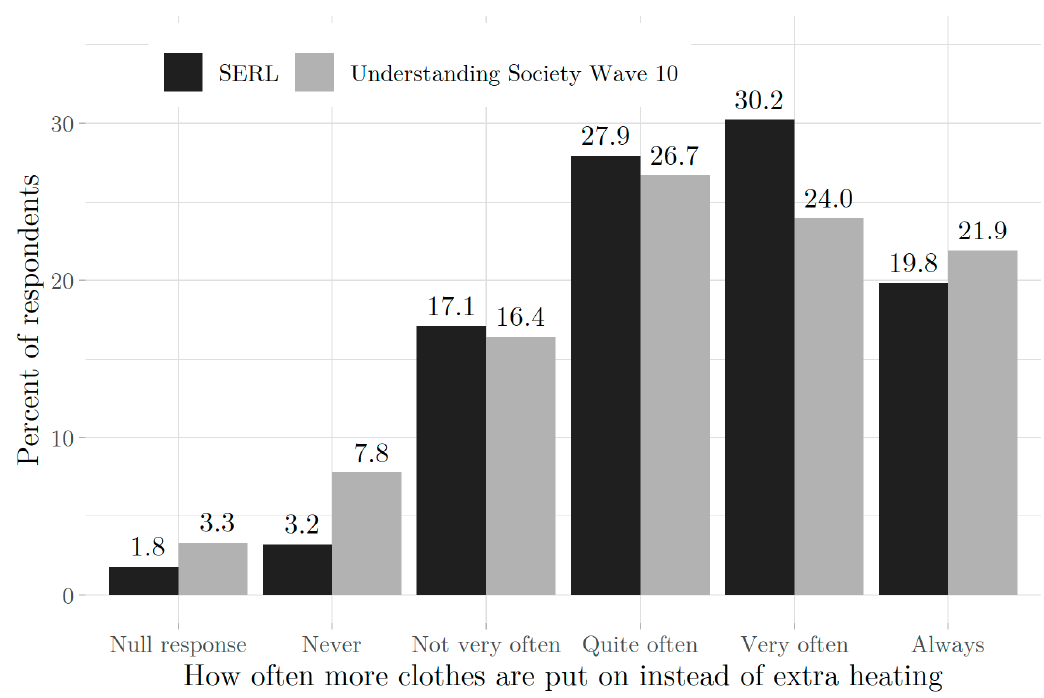
Figure 13. Responses given to question A13b about saving energy by choosing to wear more clothes over using more heating (SERL survey respondents compared to Understanding Society Wave 10).